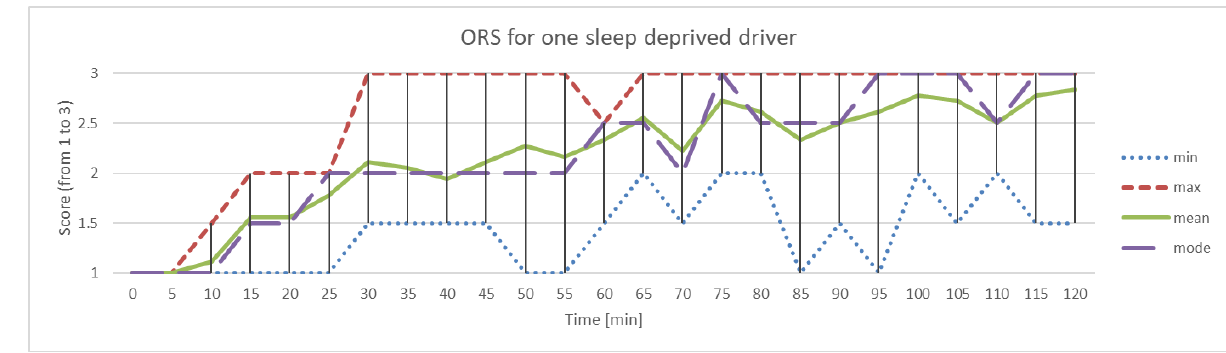
Figure 2. Results for ORS evaluation by 9 observers of one sleep deprived subject.